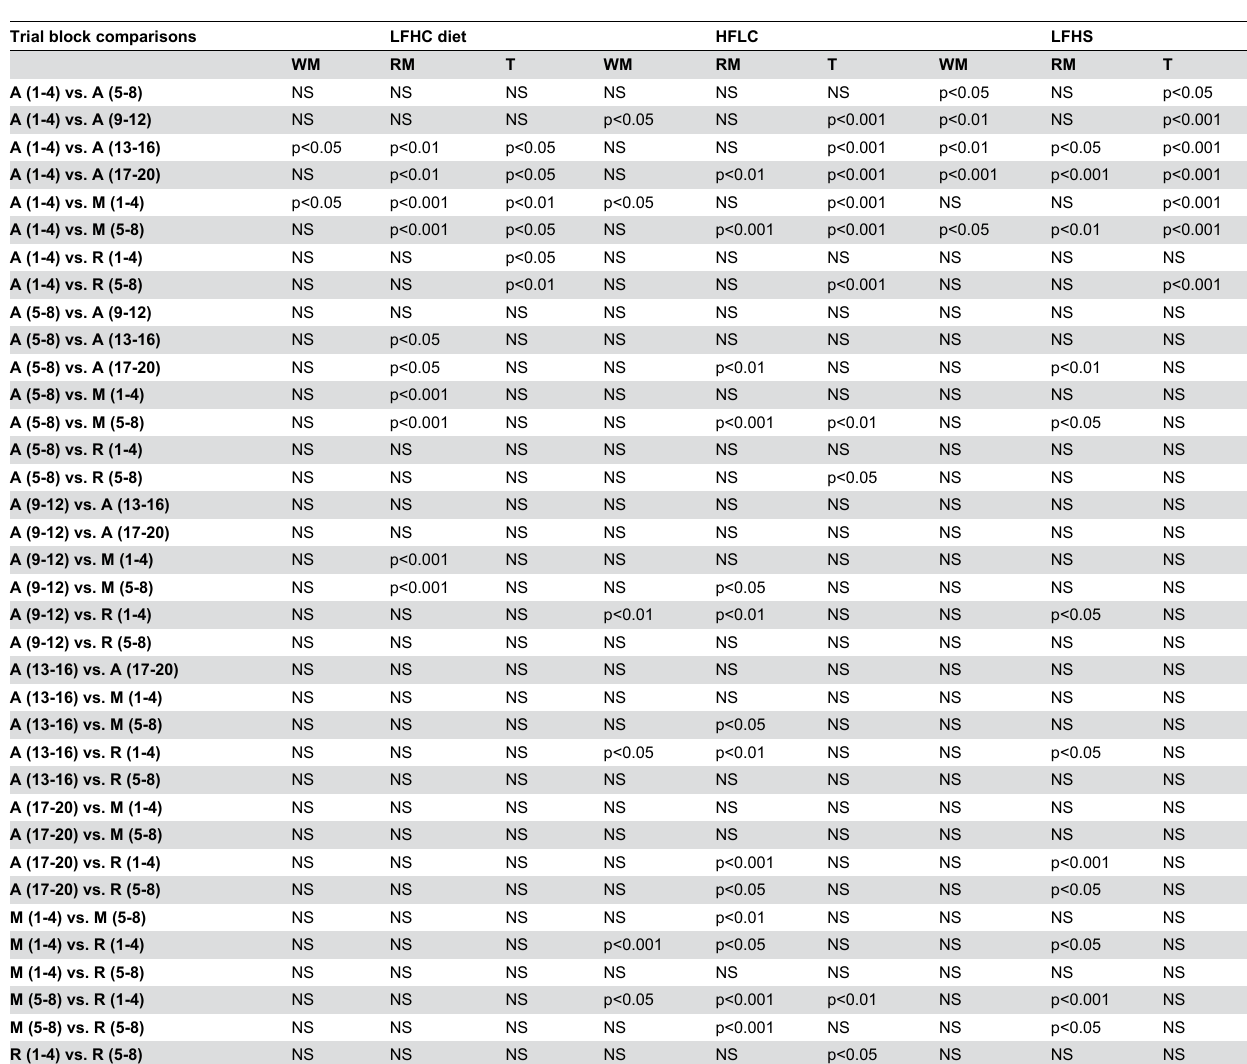
Table 2. Trial block effect on performance of minipigs in the spatial hole-board discrimination test.